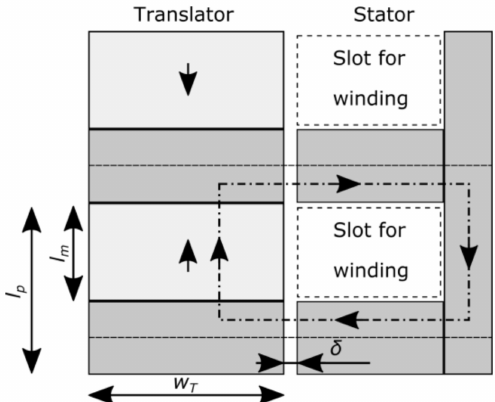
A section of a cross section of a simplified linear generator is shown, where the two-dimensional (2D) magnetic circuit that is used to calculate the flux at direct position is drawn. The dashed lines are symmetry lines that mark the boundaries of the magnetic circuit. Ferrite magnets are in light grey, iron is in dark grey, and air is in